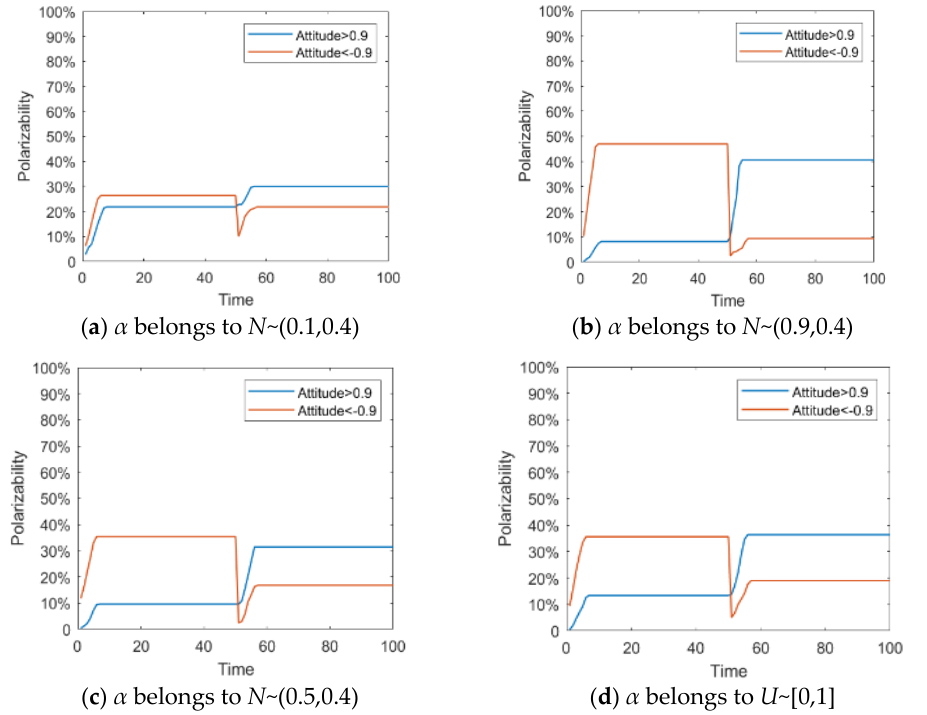
Figure 10. Curve of group attitude polarization under different distribution of attention.( a ) α belongs to N ~(0.1,0.4); ( b ) α belongs to N ~(0.9,0.4); ( c ) α belongs to N ~(0.5,0.4); ( d ) α belongs to U ~[0,1].